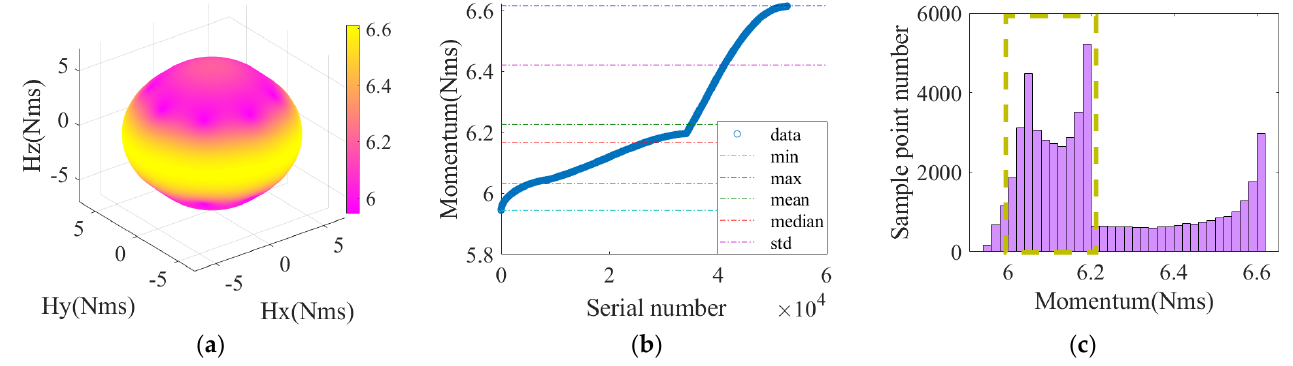
Figure 3. Momentum characteristics of 8−SGCMGs. ( a ) Momentum envelope, ( b ) Sample arrange- ment, ( c ) Sample number statistics.